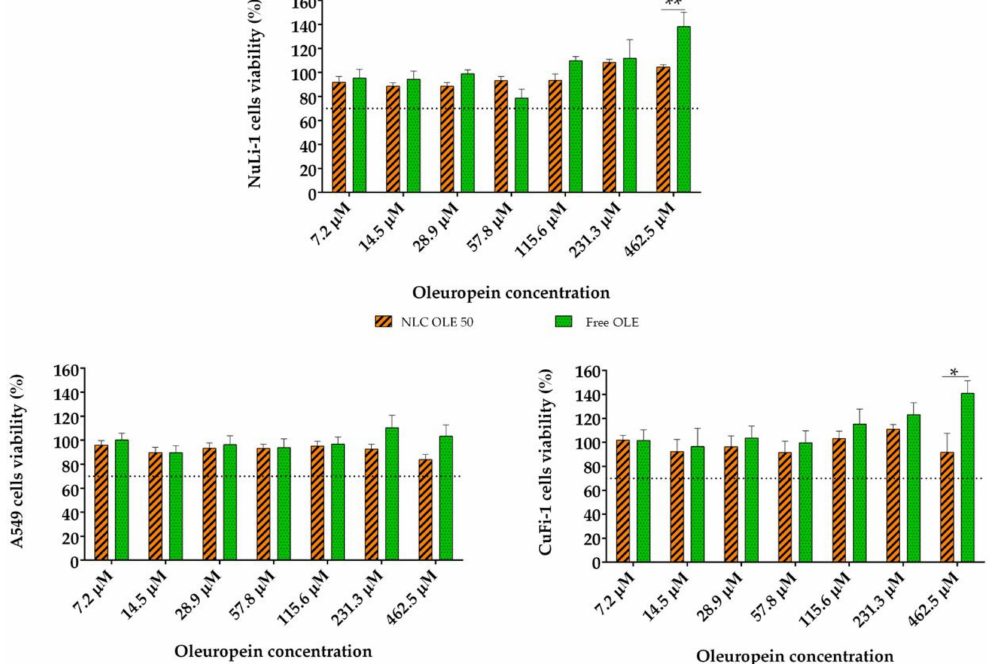
Figure 4. E ff ect of nanoencapsulated (NLC-OLE50) and free oleuropein (OLE) at di ff erent concentrations on the viability of the A549, NuLi-1, and CuFi-1 cell lines among 24 h. The results are given as the mean % of living cells compared to the control ± SD, n = 3. * p < 0.05, ** p <